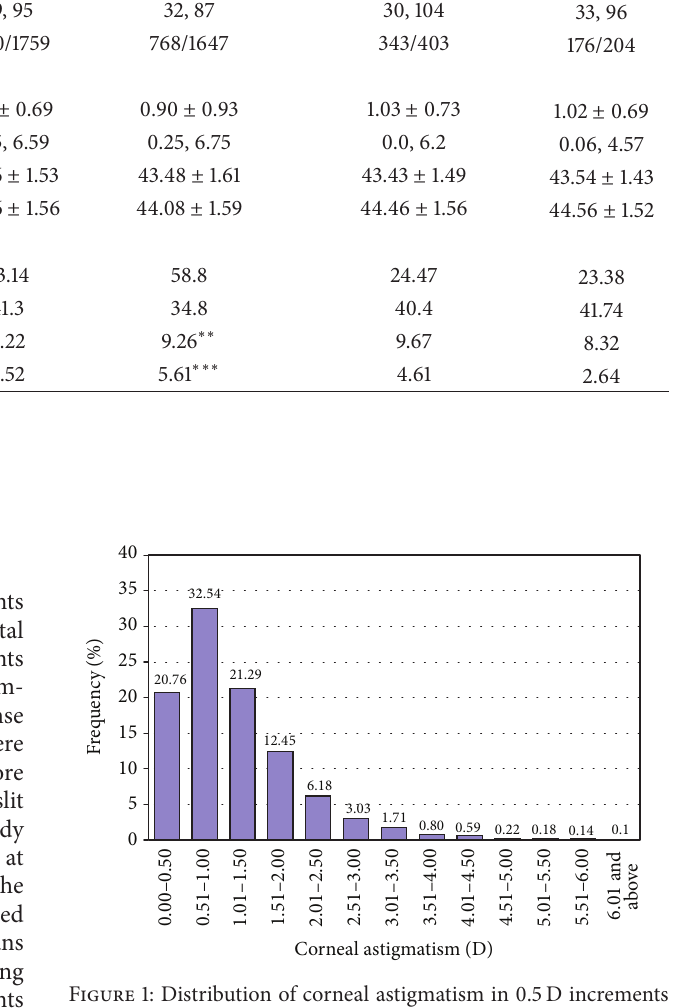
Figure 1: Distribution of corneal astigmatism in 0.5 D increments for all 12,449